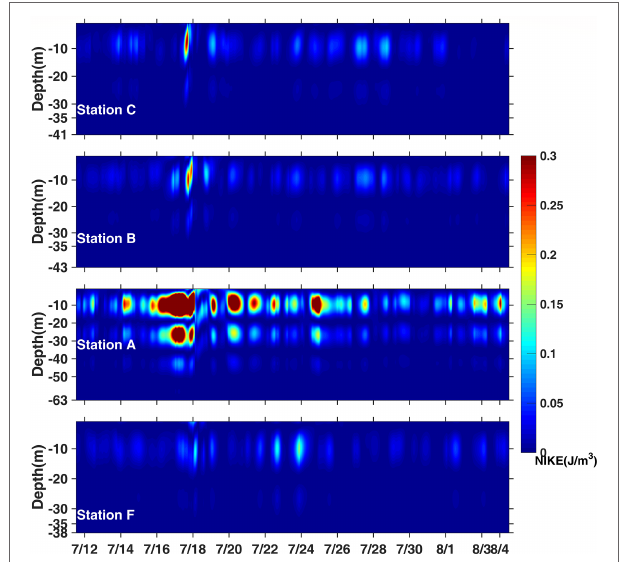
FIGURE 11 | (A) Spectra analyses of modeled depth-averaged hourly velocity at station B. The across-shore (along-shore) component is u (v); (B–I) time series of vertical profiles of near-inertial flow at Stations C, B, A, and F from July 12 to August 4. Here (B, D, F, H) are across-shore component; (C, E, G, I) are along-shore component. The model simulated hourly current data are used in the calculation.